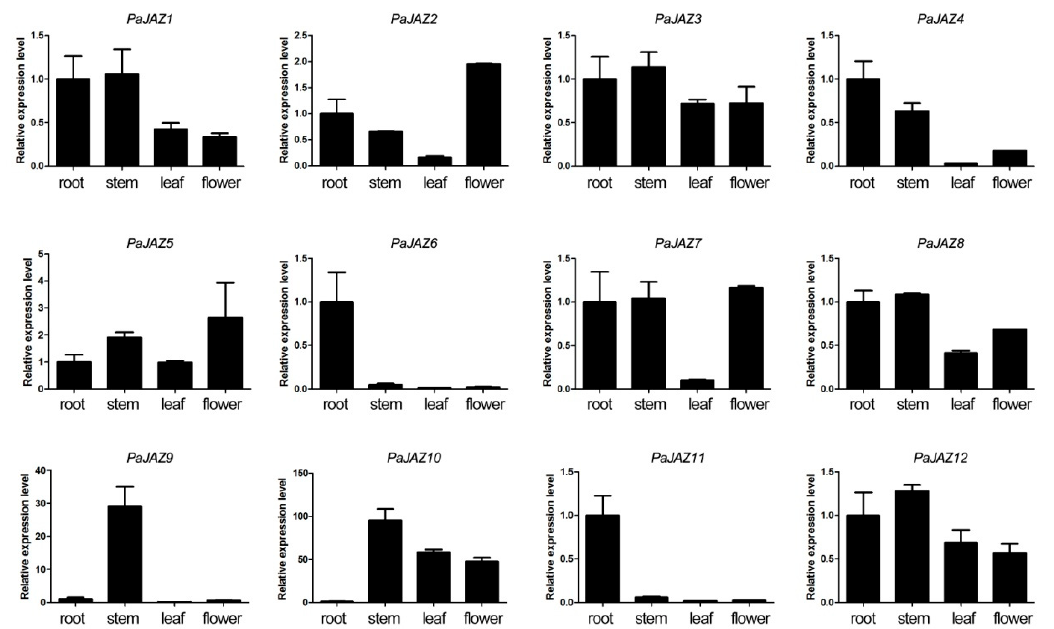
Figure 4. The expression patterns of PaJAZ genes in different petunia tissues. The RNA samples of roots, stems, leaves, and flowers were extracted from P. hybrida ‘Fantasy Red’. The expression levels of PaJAZ genes were detected by the 2 − △△ Ct method with petunia β -actin gene as the internal control, and the expression in the root was defined as one. The data were calculated from three replications and presented as mean values ± standard error.